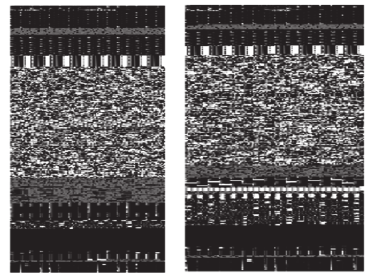
Figure 5. Image of goodware.